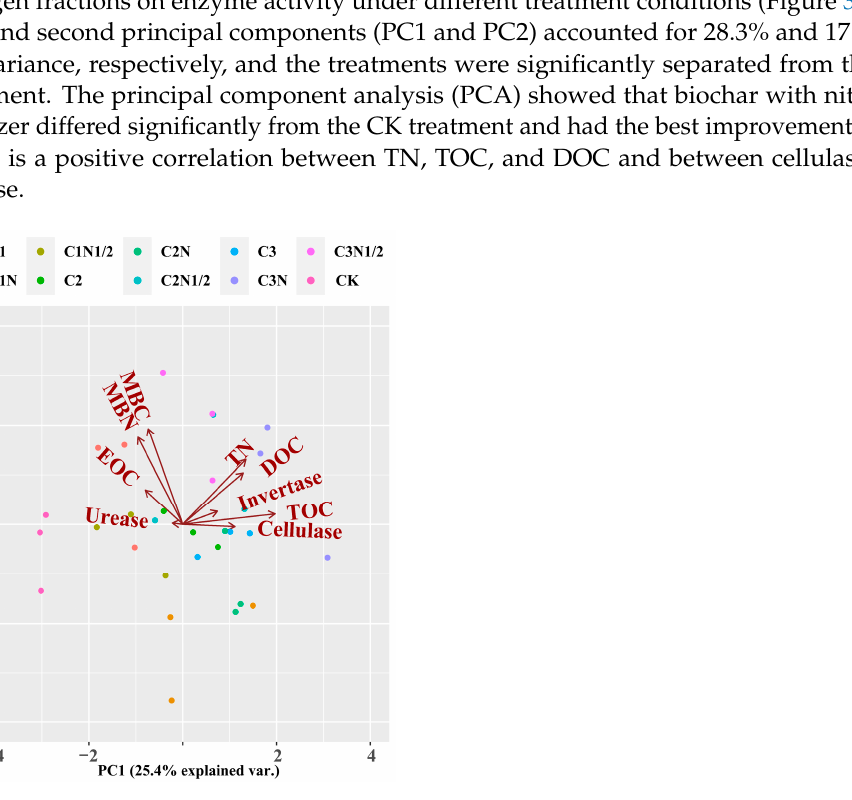
Figure 3. Principal component analysis of soil enzyme activity and soil carbon and nitrogen fractions.